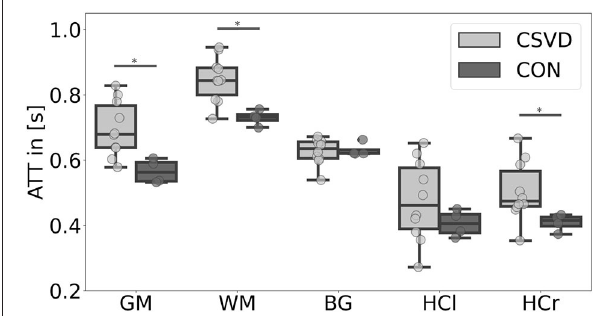
FIGURE 2 | Mean arterial transit time (ATT) differences between patients with cerebral small vessel disease (CSVD) and controls (CON) for several regions-of-interest. Significant group differences ( p < 0.05) of mean gray matter (GM), white matter (WM), and right hippocampus (HCr) ATT are marked with *; there were no significant ATT group differences for the basal ganglia (BG) and left hippocampus (HCl) ROI ( p >